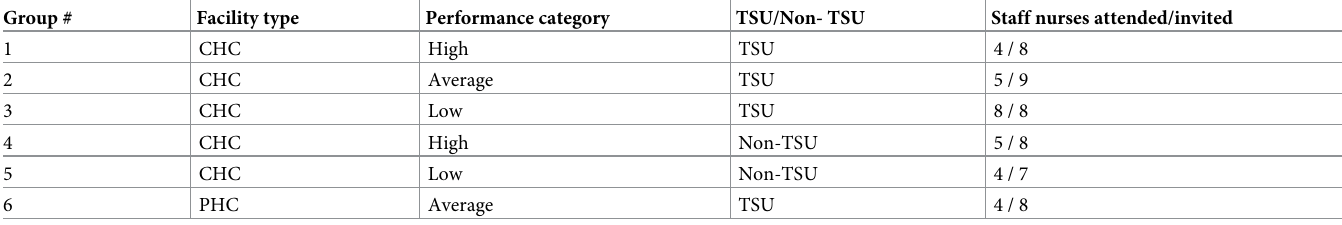
Table 1. Main facility and nurse sample for the decision-making game. Group